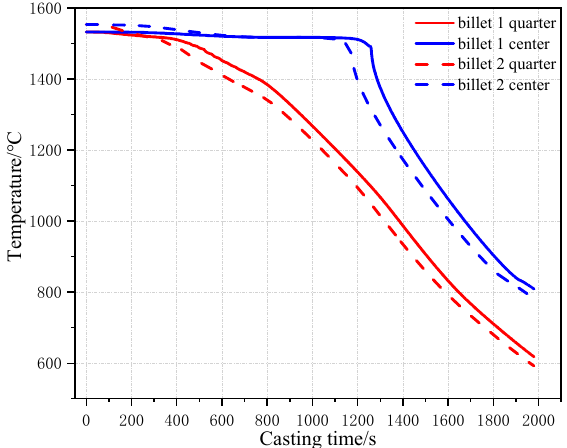
Figure 8. The temperature of the quarter and center positions of the billet in the solidification process.